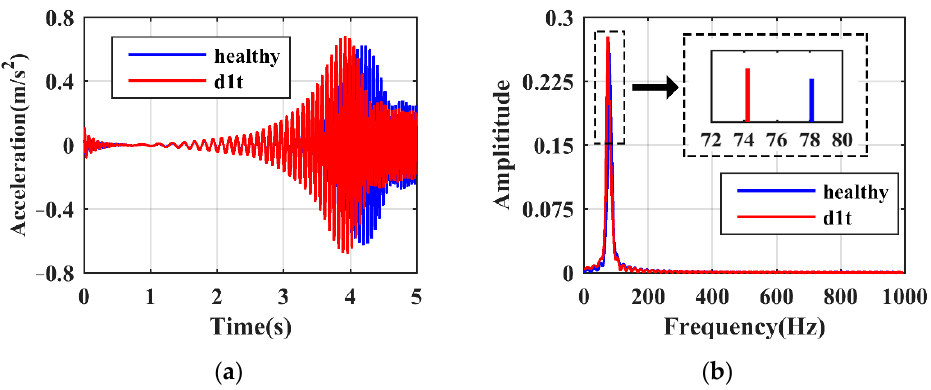
Figure 7. Damage characteristics of case ‘d1t’: ( a ) time domain; ( b ) frequency domain.